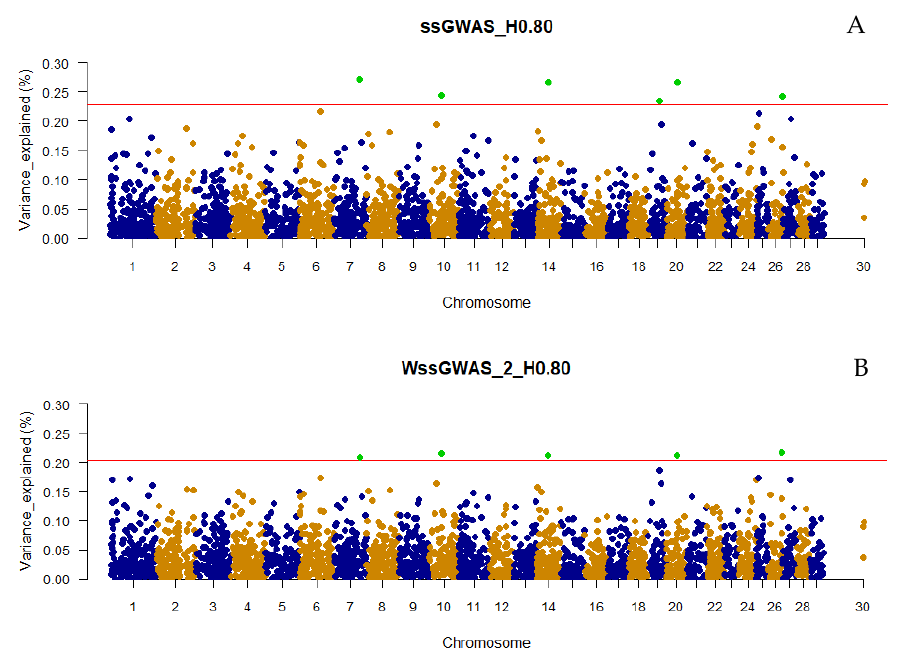
Figure 3. Manhattan plot of the percentage of the total additive genetic variance explained by haplotypes from haploblocks built with a linkage disequilibrium threshold of 0.50 for yearling temperament in American Angus cattle using single-step GWAS (ssGWAS_H0.50; A ) and weighted single-step GWAS in the second (WssGWAS_2_H0.50; B ) and third (WssGWAS_3_H0.50; C ) iterations. Green points highlighted above the red horizontal line are the top 0.001% markers that explained greater percentages of the total additive genetic variance for YT. The X-chromosome (PAR region) is represented by the chromosome 30.